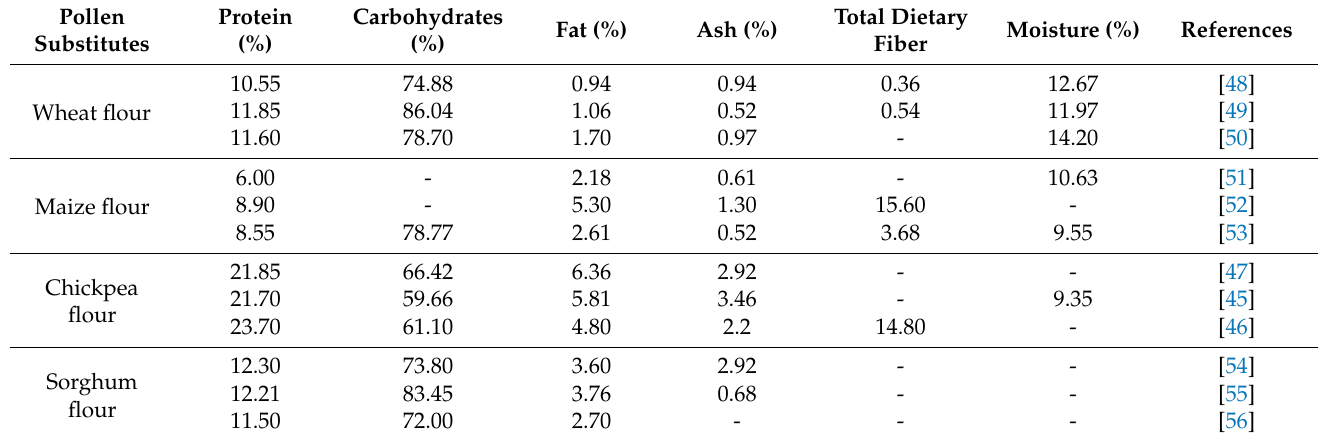
Table 3. Nutritional content of pollen substitutes reported in different